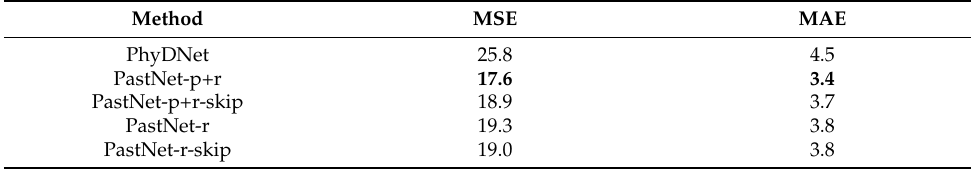
Table 3. MSEs and MAEs for air temperature prediction